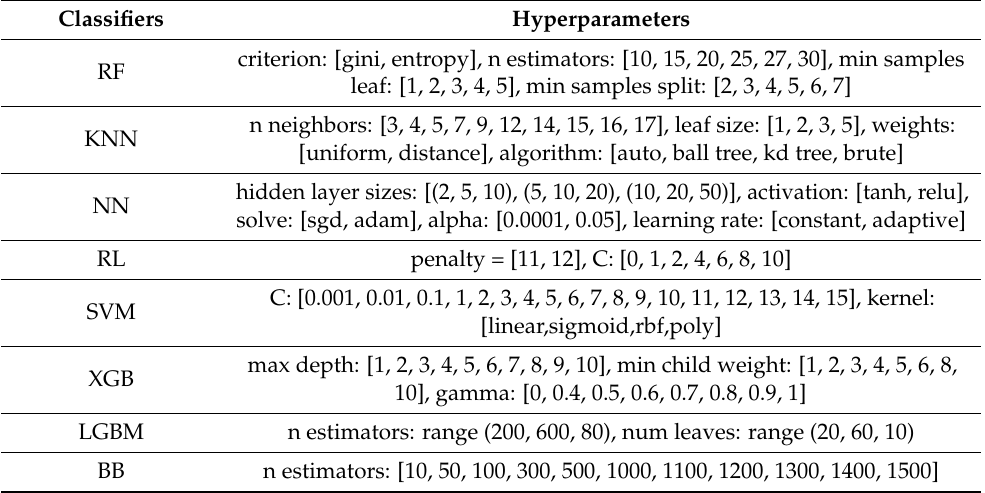
Table 2. Hyperparameters of the selected ML